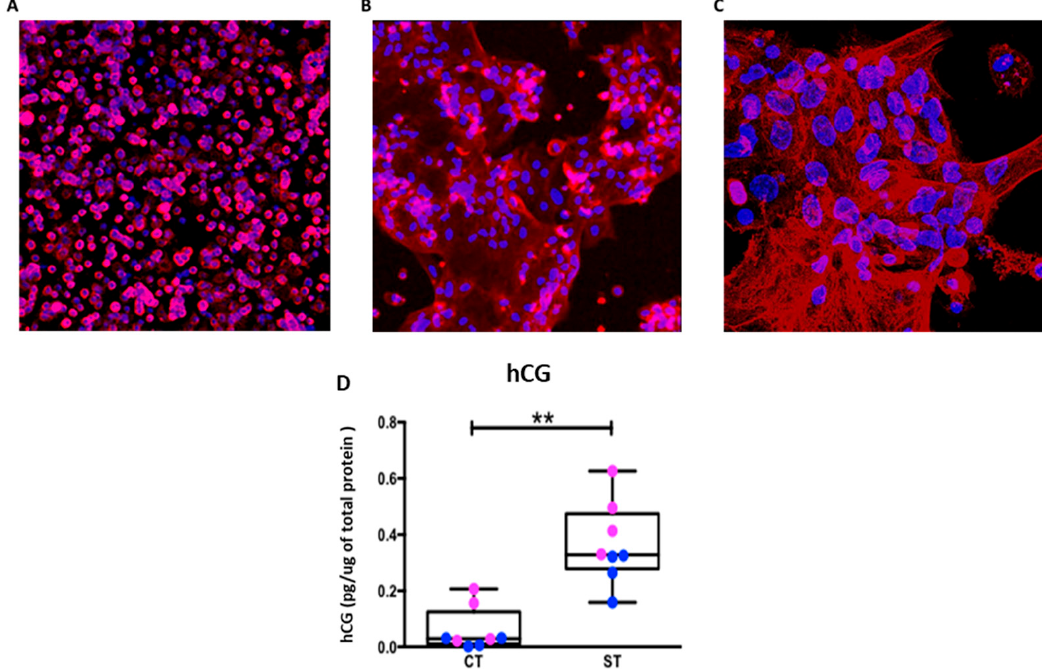
Figure 1. Identification of trophoblast cells and their syncytialization. ( A ) Cytotrophoblast at 24 h (20 × ), ( B ) Syncy- tiotrophoblast at 96 hrs (20 × ), and ( C ) Syncytiotrophoblast (63 × ) stained with cytokeratin 7 (red) and counterstained with Hoechst 33,342 for nuclei (blue). ( D ) Human Chorionic Gonadotropin (hCG) production pg of hormone per µ g of cell protein. Data presented as minimum, maximum, median, 25th and 75th quartiles boxes, and whisker plots, n = 8, male = blue, female = pink. ** p < 0.01, (Wilcoxon test CT vs. ST).